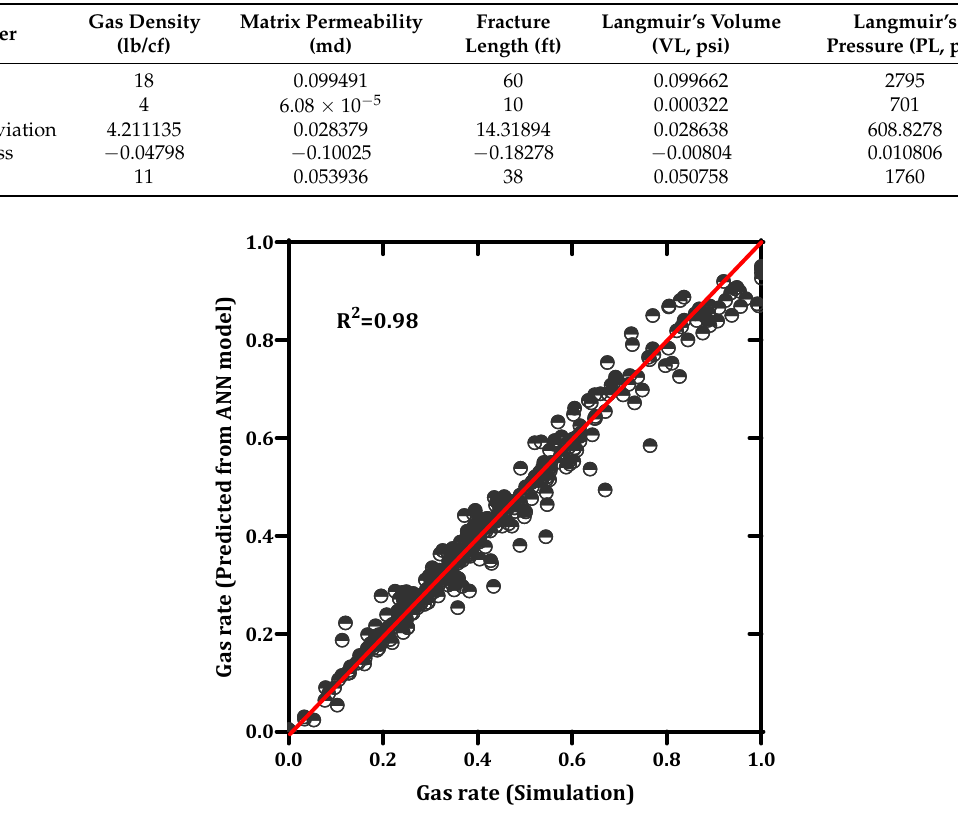
Table 3. Statistics analysis of the input data.